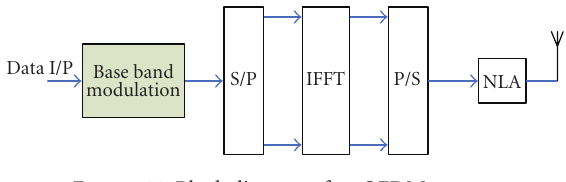
Figure 11: Block diagram of an OFDM system. Table 2: PAR, STD, and dynamic range of OFDM